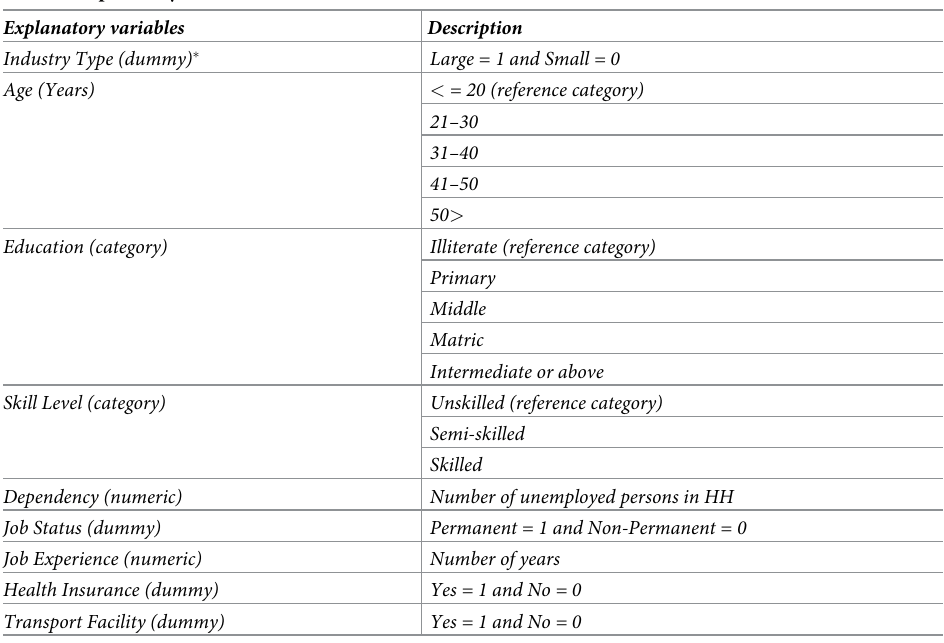
Table 1. Explanatory